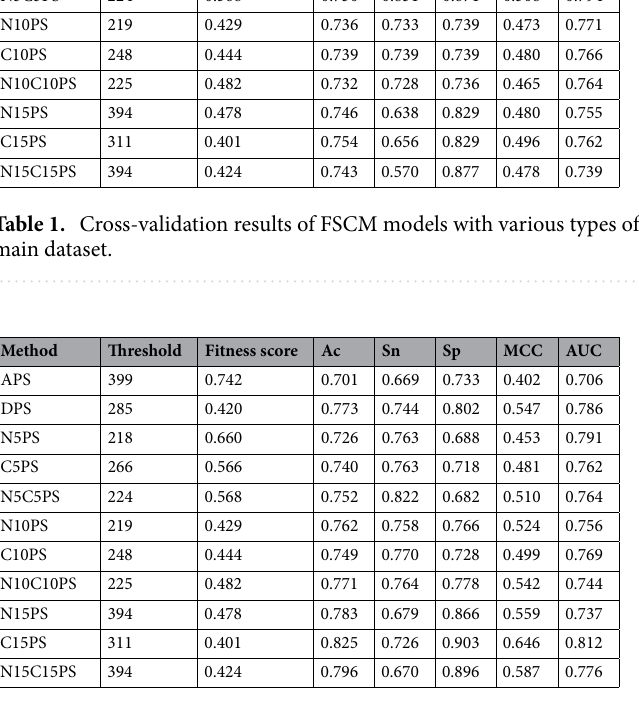
Table 2. Independent test results of FSCM models with various types of sequence features as evaluated on the main